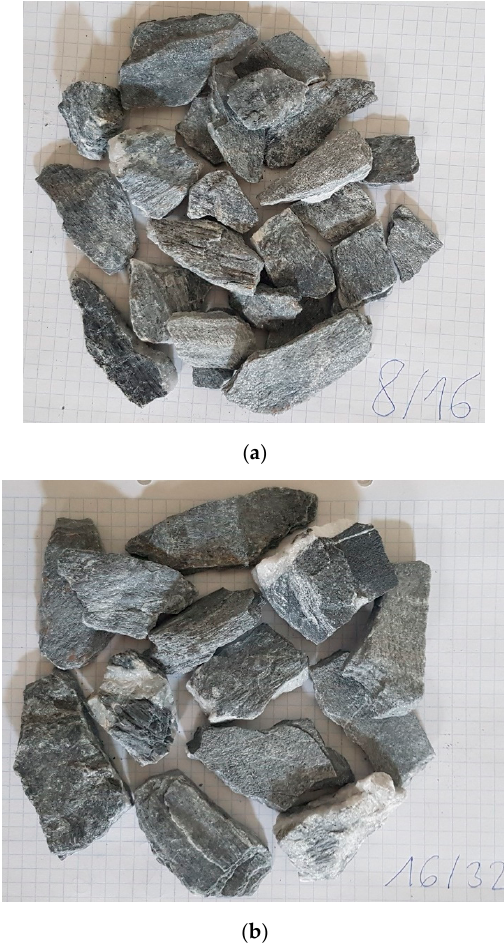
Figure 6. ( a ) Bündner Schist aggregate 8 / 16 and ( b ) Bündner Schist aggregate 16 / 32 mm from tunnel boring machine driving (washed, but without any processing) illustrating the elongated and platy shape of